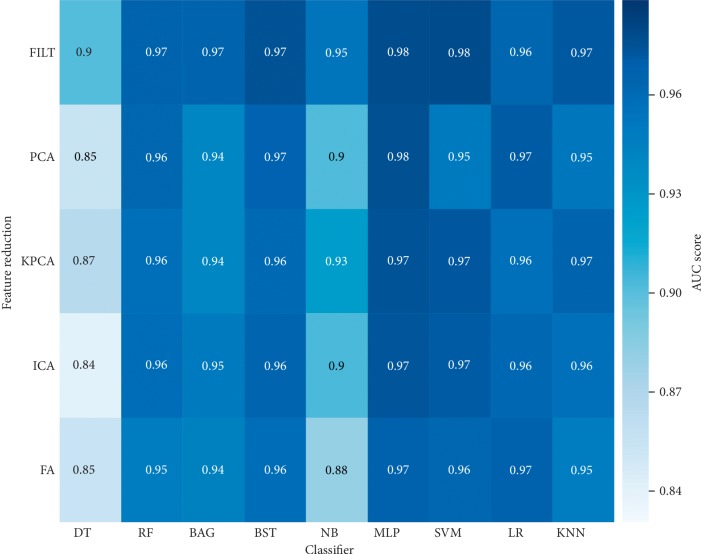
Heat map with HSASR.